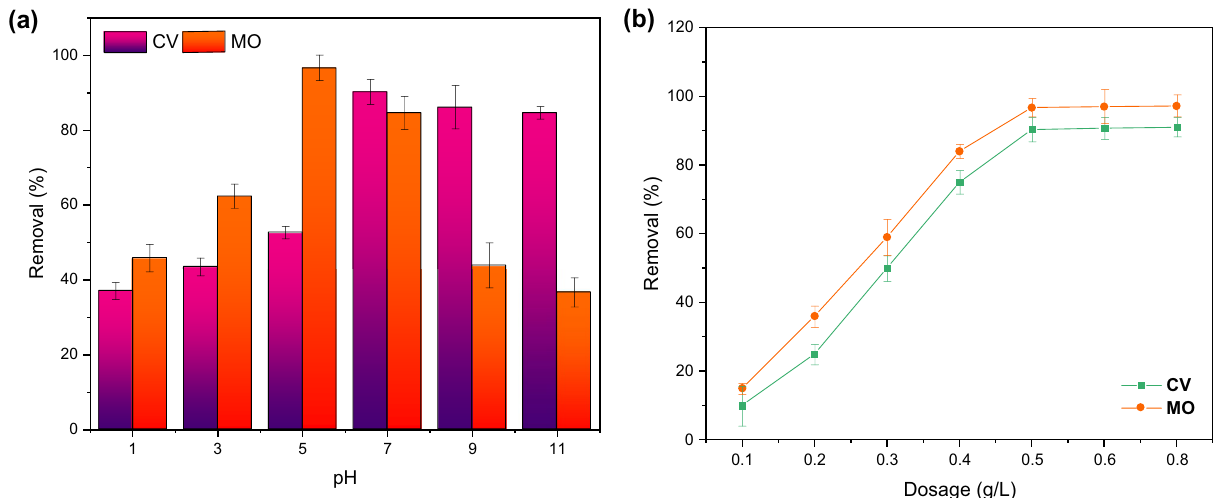
Figure 4. ( a ) Effect of solution pH ( C a = 0.5 g/L, C dye = 25 mg/L); ( b ) Effect of adsorbent dosage (optimum pH = 7 for CV and 5 for MO) on the dye removal efficiency; T = 25 °C, t = 180